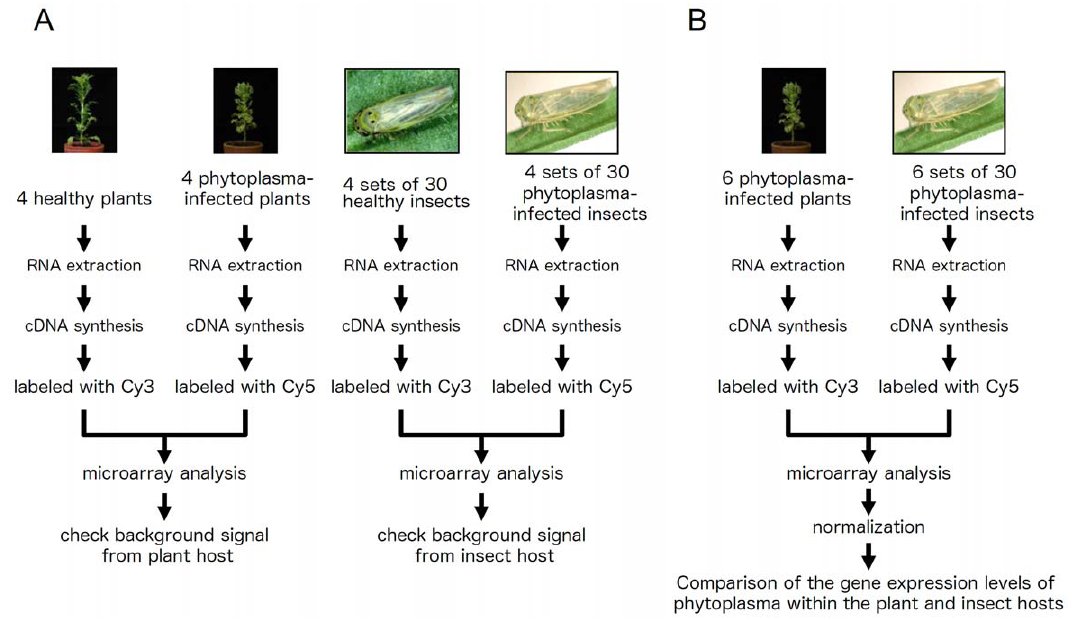
Figure 2. Experimental designs to compare the gene expressions between OY-M grown in plant and OY-M grown in insect host. (A) To evaluate the OY-M gene expression when grown in plant and to evaluate the background signal from plant host, total RNA was extracted from healthy plants and OY-M-infected plants, and labeled with Cy3 and Cy5, respectively. By subtracting the background signals of healthy plants, OY-M gene expression in plant host was obtained. Also, we obtained data on OY-M gene expression when grown in insect host by subtracting the background signals of healthy insect, and checked the background signal from insect host. (B) To investigate gene expression profiles between OY-M grown in plant host and OY-M grown in insect host, total RNA was extracted from OY-M-infected plants and OY-M-infected insects, and labelled with Cy3 and Cy5, respectively. These gene expression data were normalized by global normalization and compared.